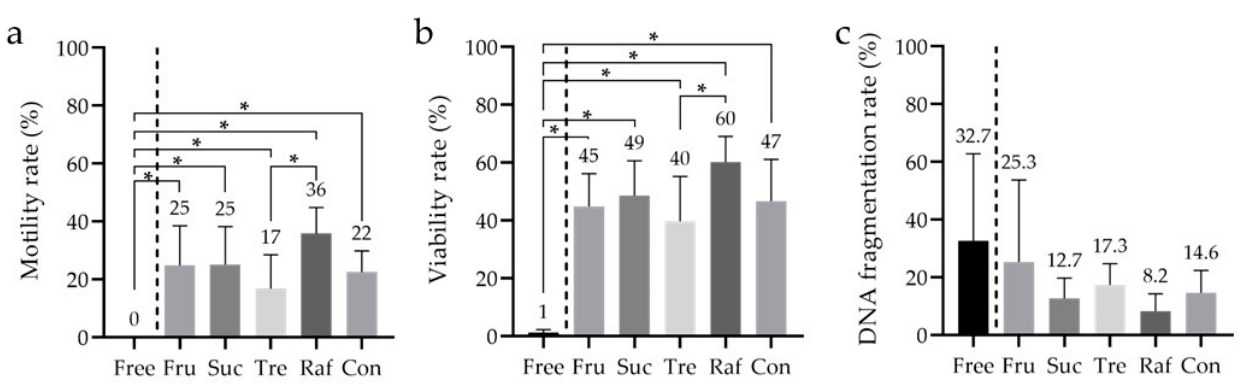
Figure 5. Sperm motility, viability, and DNA fragmentation rates after freeze–thawing with cryopreservation reagents containing different saccharides. ( a ) The motility rate was analyzed to determine the sperm cryopreservation reagent that yielded the best conditions, including the saccharides explored in Figure 4. ( b ) The viability was analyzed using the sperm viability test (SVT) with residual samples from Figure 5a. ( c ) The DNA fragmentation rate was analyzed using flow cytometry with residual samples from Figure 5a. ( a ) The low-Mw CPA was 7% v / v glycerol (Glyc), and the macro-Mw CPA was 0.3% w / v carboxylated poly- L -lysine (CPLL). Tukey’s multiple comparison test was performed in all groups except ‘Free; p -value < 0.05 was considered statistically significant. The data are expressed as the means ± standard deviations ( n = 8). Asterisks (*) indicate a statistically significant difference; Free, no saccharides; Fru, fructose; Suc, sucrose; Tre, trehalose; Raf, raffinose; low-Mw CPA, low-molecular-weight cryoprotective agent; macro-Mw CPA, macromolecular-weight cryoprotective agent; Con, commercial cryopreservation reagent (Fujifilm Irvine).